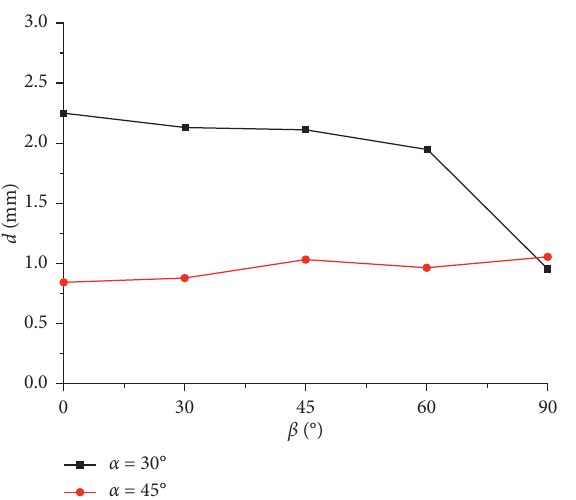
Figure 6: Variations of crack initiation locations with β .